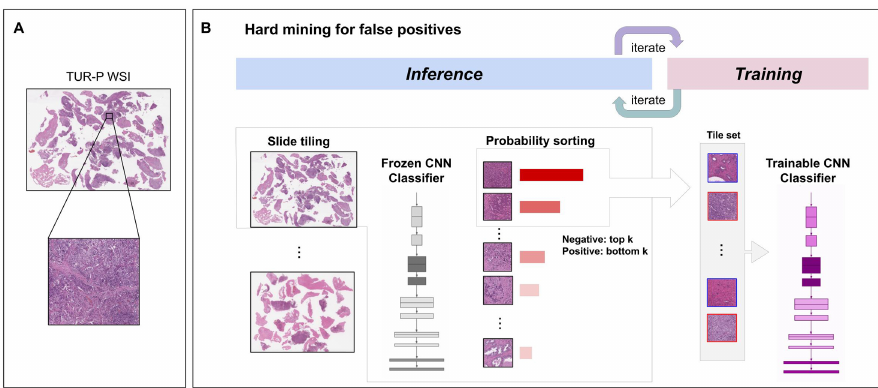
Figure 1. Schematic diagrams of training method overview. ( A ) shows a representative transurethral resection of the prostate (TUR-P) whole-slide image (WSI) (65,736 × 47,326 px) with a zoomed-in tile (224 × 224 px). ( B ) During training, we iteratively alternated between inference and training. During the inference step, model weights were frozen, and the model was used to select tiles with the highest probability after applying it on entire tissue regions of each WSI. The top k tiles with the highest probabilities were then selected from each WSI and placed into a queue. During training, the selected tiles from multiple WSIs formed a training batch and were used to train the